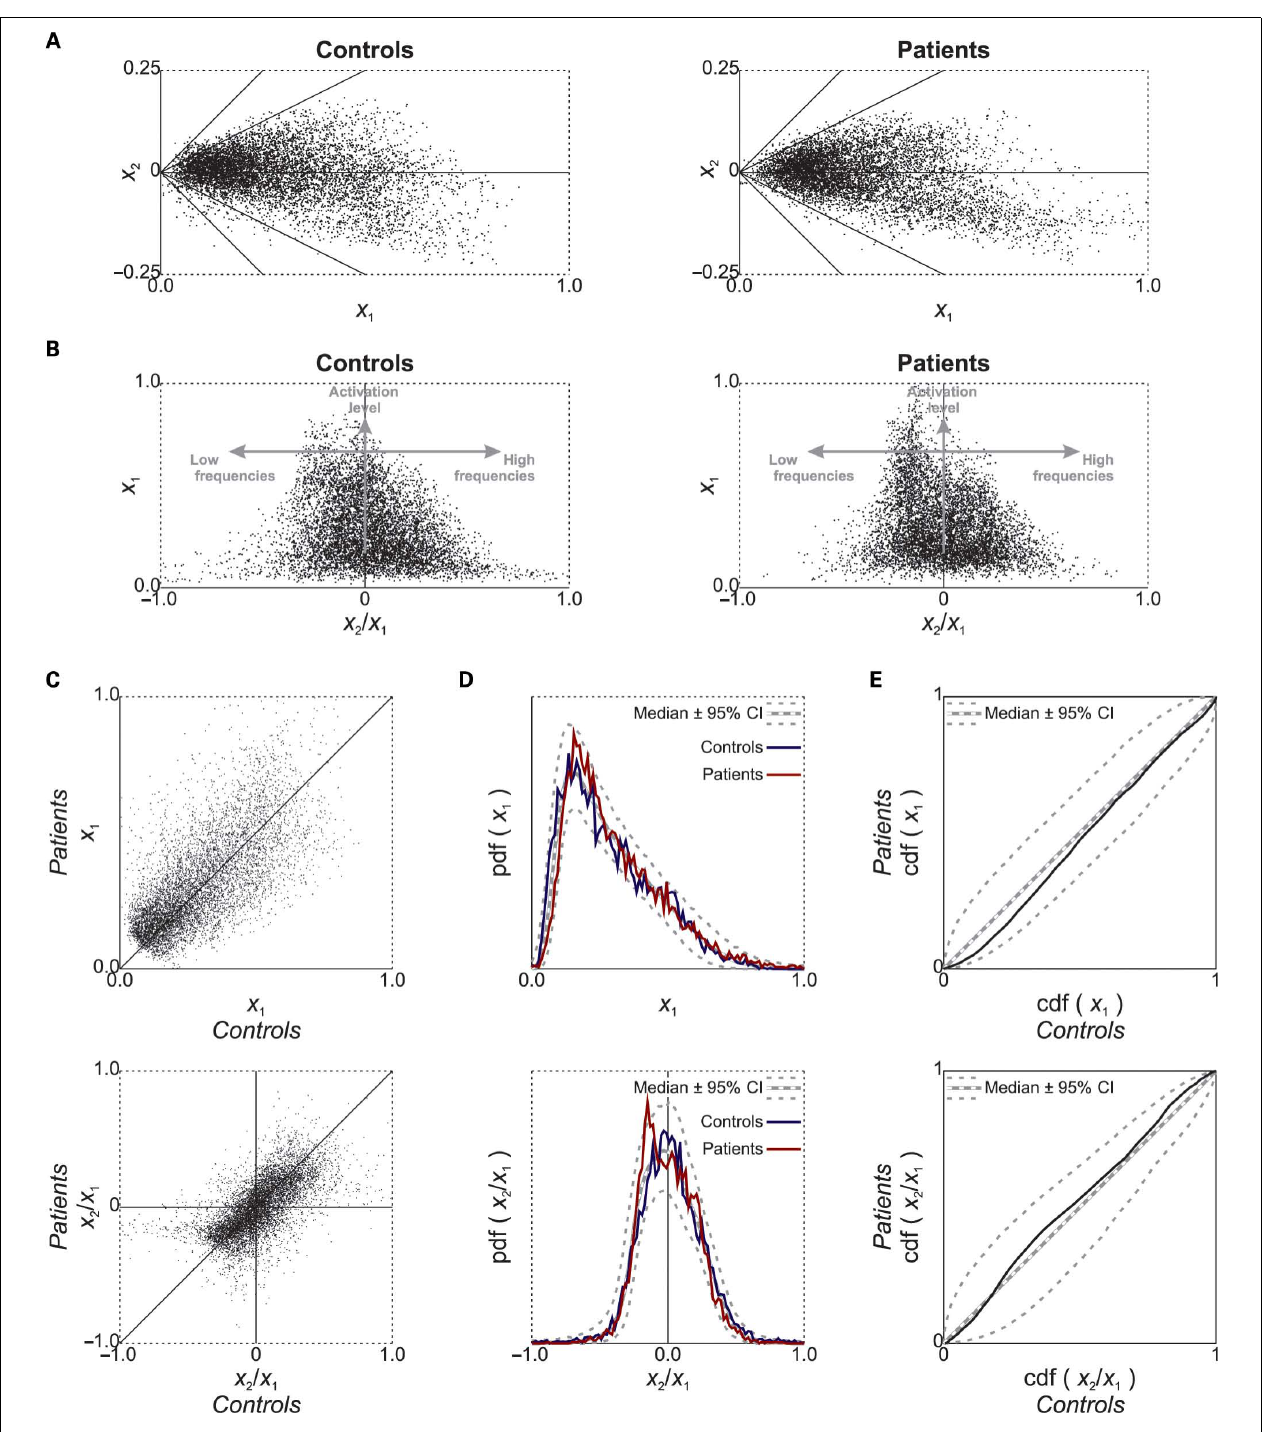
FIGURE 4 | (A) The coefficients in the first and second components’ spatial response maps (see Figure 3B ) were plotted against each other. Each data point corresponds with one voxel.The diagonal lines show where the ratio x 2 / x 1 remains constant. (B) Transforming the representation in (A) , the ratio of the first and second components’ coefficients was plotted against the coefficient of the first component.The vertical coordinate of a voxel’s data point reflects its sound-evoked activation level, and the horizontal coordinate reflects its frequency tuning. (C) A plot of the sound-evoked activation level